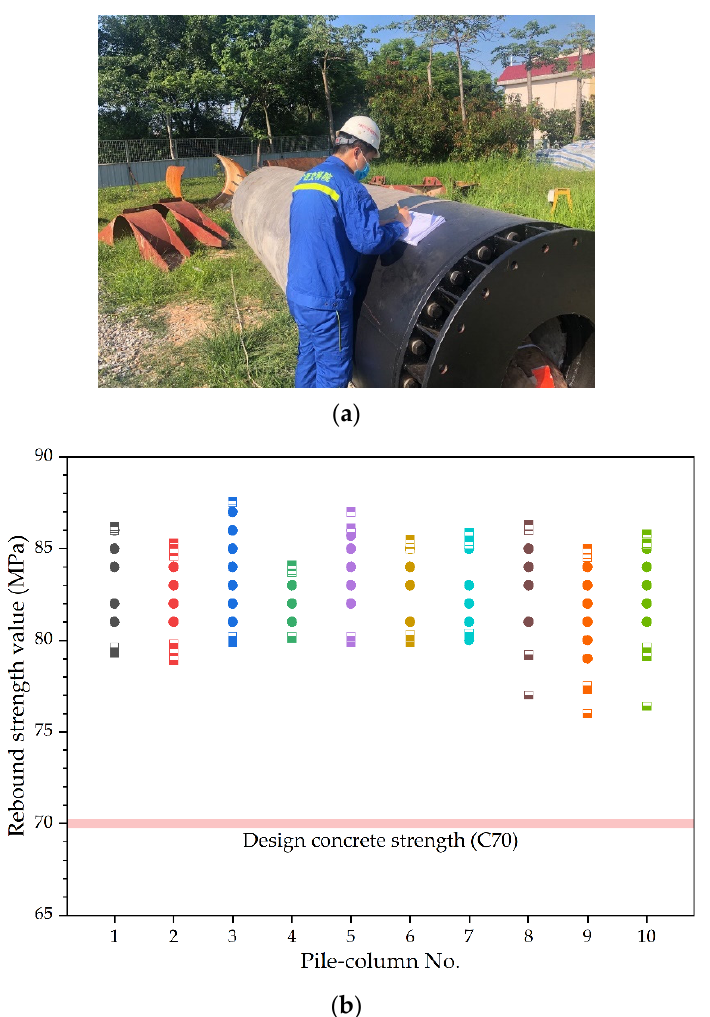
Figure 3. Concrete strength of prefabricated pile ‐ column: ( a ) the concrete strength monitoring test of a prefabricated pile ‐ column using a digital display rebound instrument; ( b ) the rebound values of 10 prefabricated pile ‐ columns after curing for 30 days.